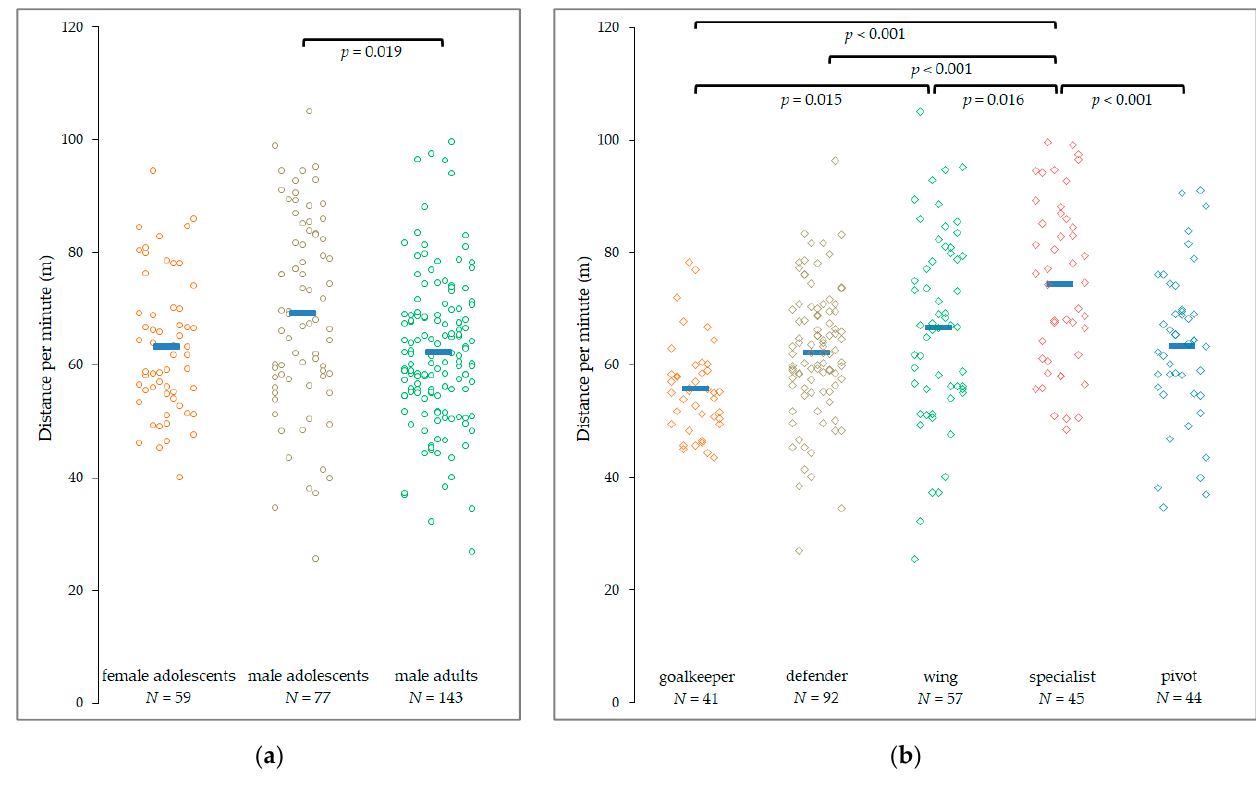
Figure 1. Distance per minute traveled across the subgroups: ( a ) subgroup 1 (age/sex); ( b ) subgroup 2 (playing position). Blue horizontal lines indicate the mean value. Table 3. Player load, maximum acceleration, and number of explosive